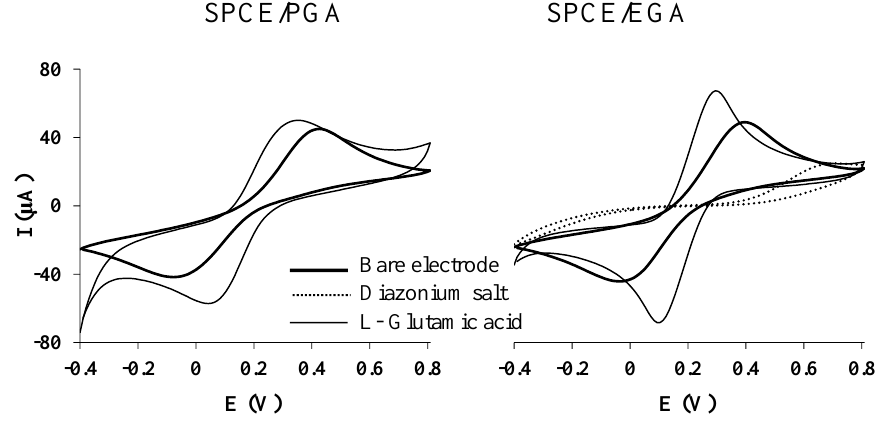
Figure 2. CVs plots recorded at each functionalization step for SPCE/PGA and SPCE/EGA. Measurements were performed in a 2 mmol L − 1 ferrocyanide/ferricyanide solution in phosphate buffer at pH 7.4 by using a scan rate of 100 mV s − 1 .